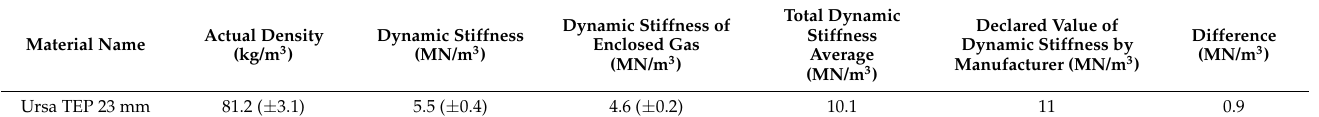
Table 5. Results of measurement of dynamic stiffness of tested samples of Ursa TEP 23 mm mineral wool, with CI = 95% (10 samples).